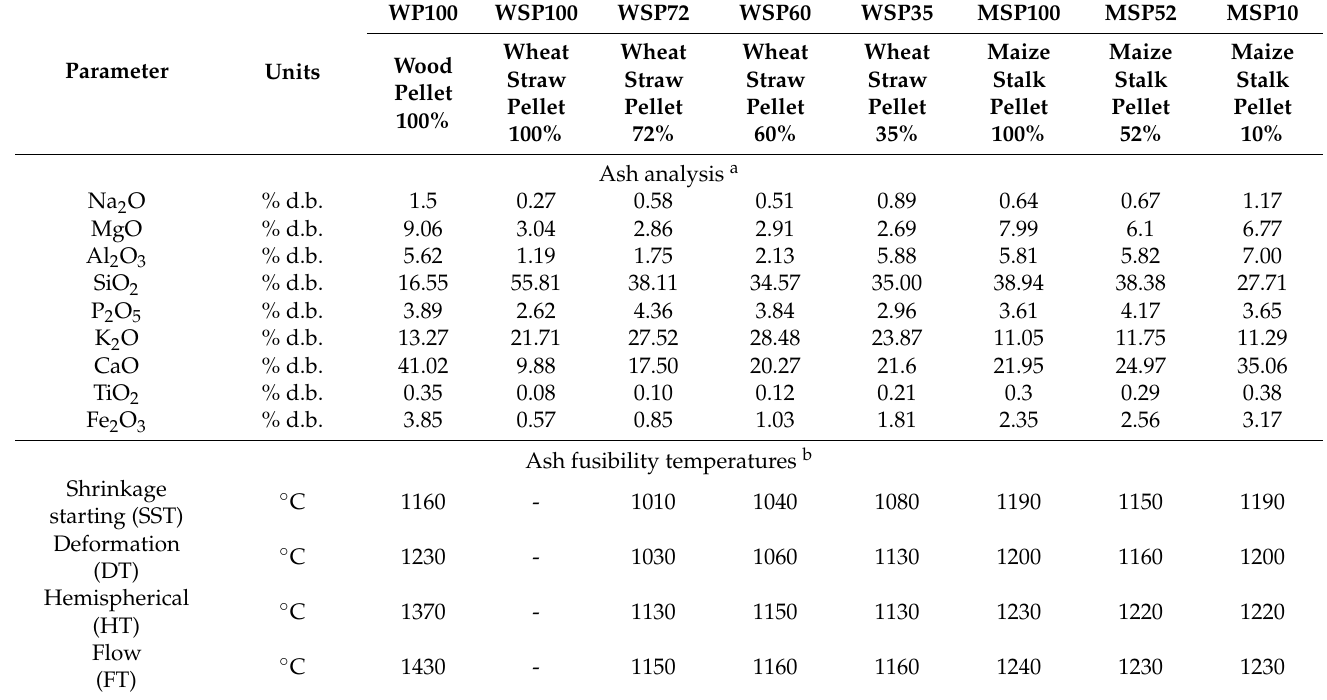
Table 3. Ash fuel properties (% d.b.: weight percentage in dry